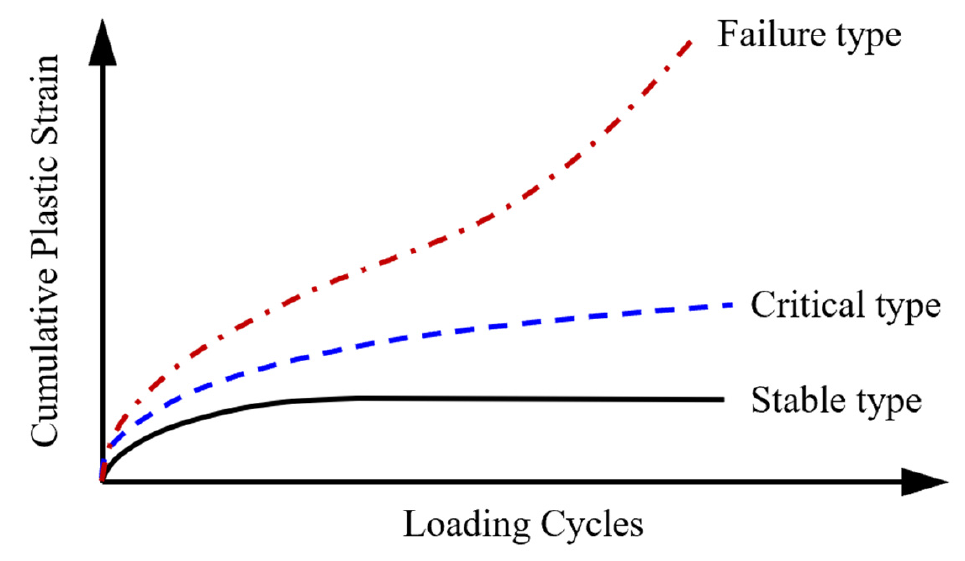
Figure 6. Schematic diagram of different permanent deformation behaviors of unbound aggregate base materials.